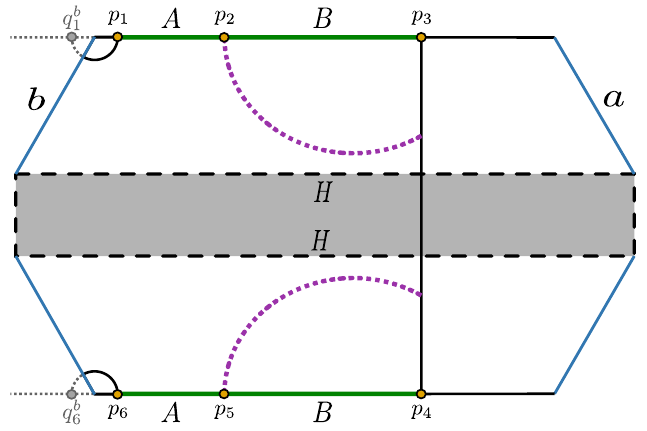
Figure 12 . The points in the two copies of BCFT 2 s in a TFD state are identified as p 2 = r 1 , p 5 = r 1 , p 3 = r 2 and p 4 = r 2